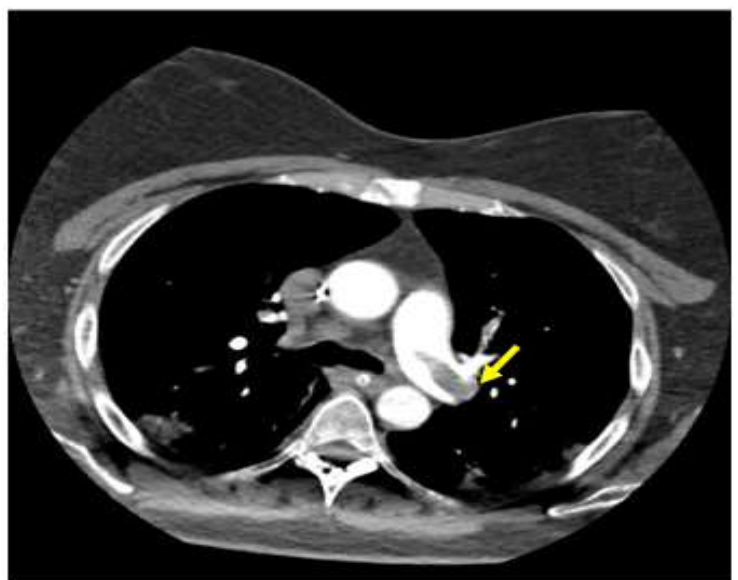
Figure 1. Computed tomography scan imaging of acute respiratory distress syndrome (ARDS) associated with COVID-19 and pulmonary emboli: pulmonary embolus across the bifurcation of the pulmonary trunk is noted, as indicated by the arrow.